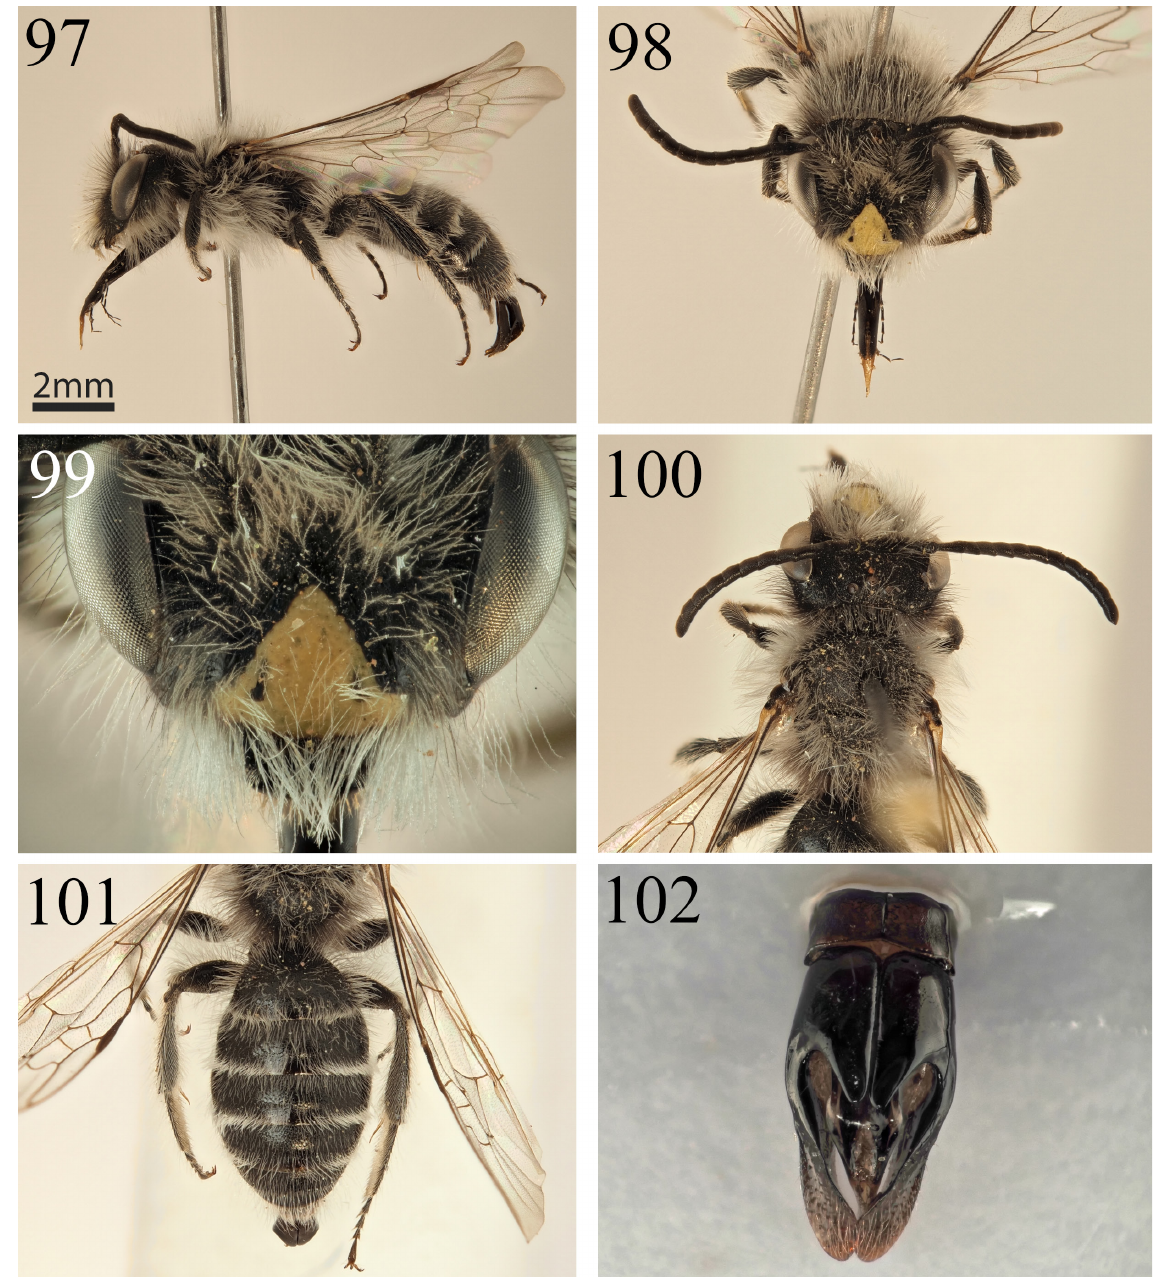
Figs 97–102. Andrena huma sp. nov., ♂ (OÖLM) . 97 . Profile. 98 . Face. 99 . Face, detail. 100 . Dorsum. 101 . Terga. 102 .